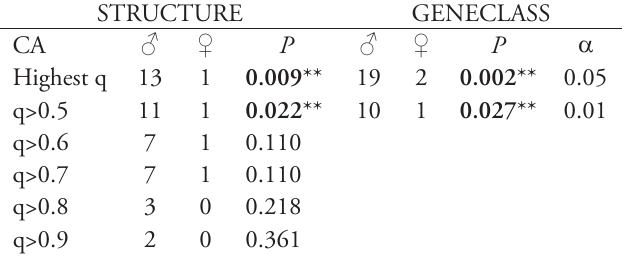
Table 5. Number of male and female first-generation dispersers among the five identified subpopulations according to STRUC- TURE with different stringency levels as criterion for assignment (CA) and according to GENECLASS with different alpha ( α ) levels. Whether the number of dispersers is higher for males than females is tested through Fishers exact tests, for which probabili- ties ( P ) are given (significant differences in